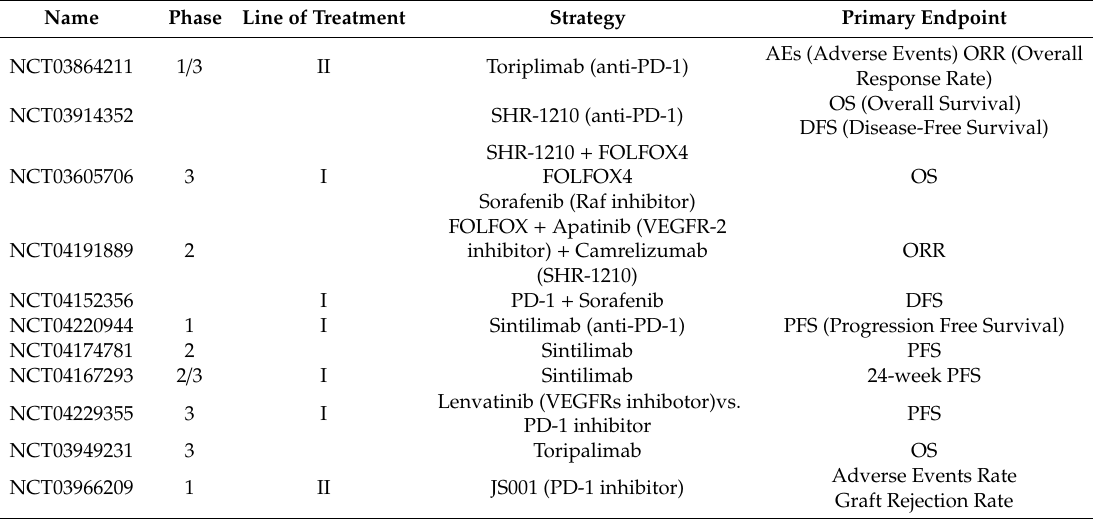
Table 4. Major trials in HCC involving anti-PD1 agents-based